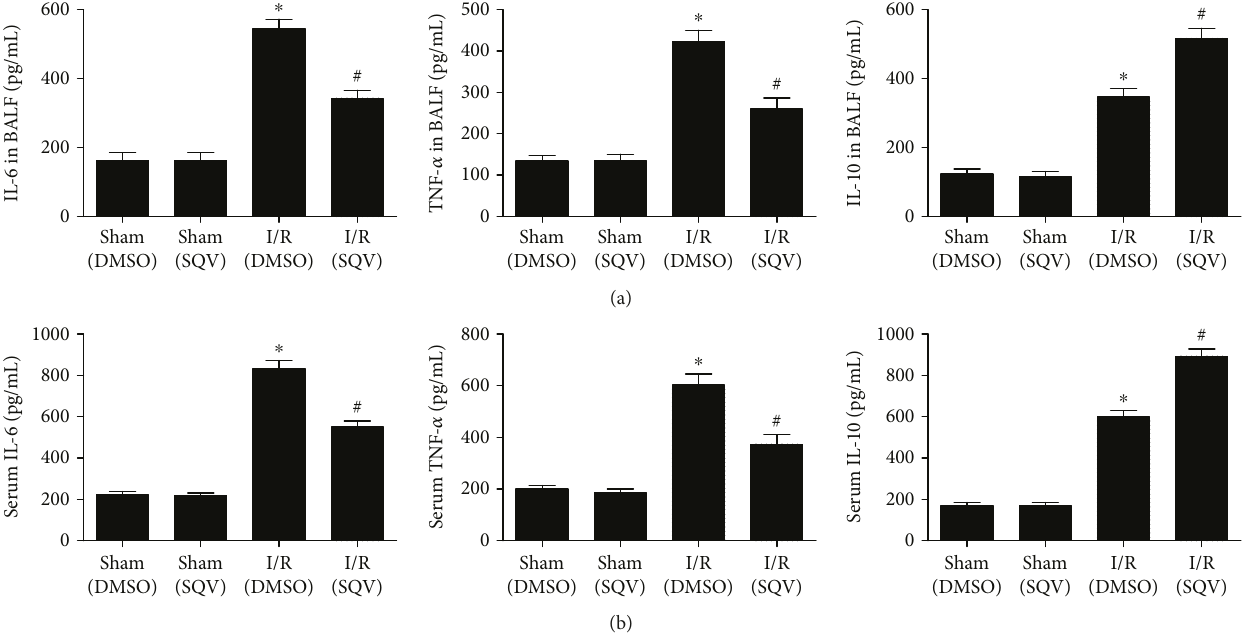
Figure 5: SQV inhibits transcriptional expression of proin fl ammatory factors and enhances transcriptional expression of anti-in fl ammatory factors in lung tissue after liver I/R. qPCR was performed to check the expression of proin fl ammatory factors of IL-6, TNF- α , IL-1 β , and iNOS (a) and anti-in fl ammatory factor, IL-10 (b). GraphPad values were presented as means ± SEM. ∗ P < 0 05 versus the Sham group; # P < 0 05 compared to the liver warm I/R